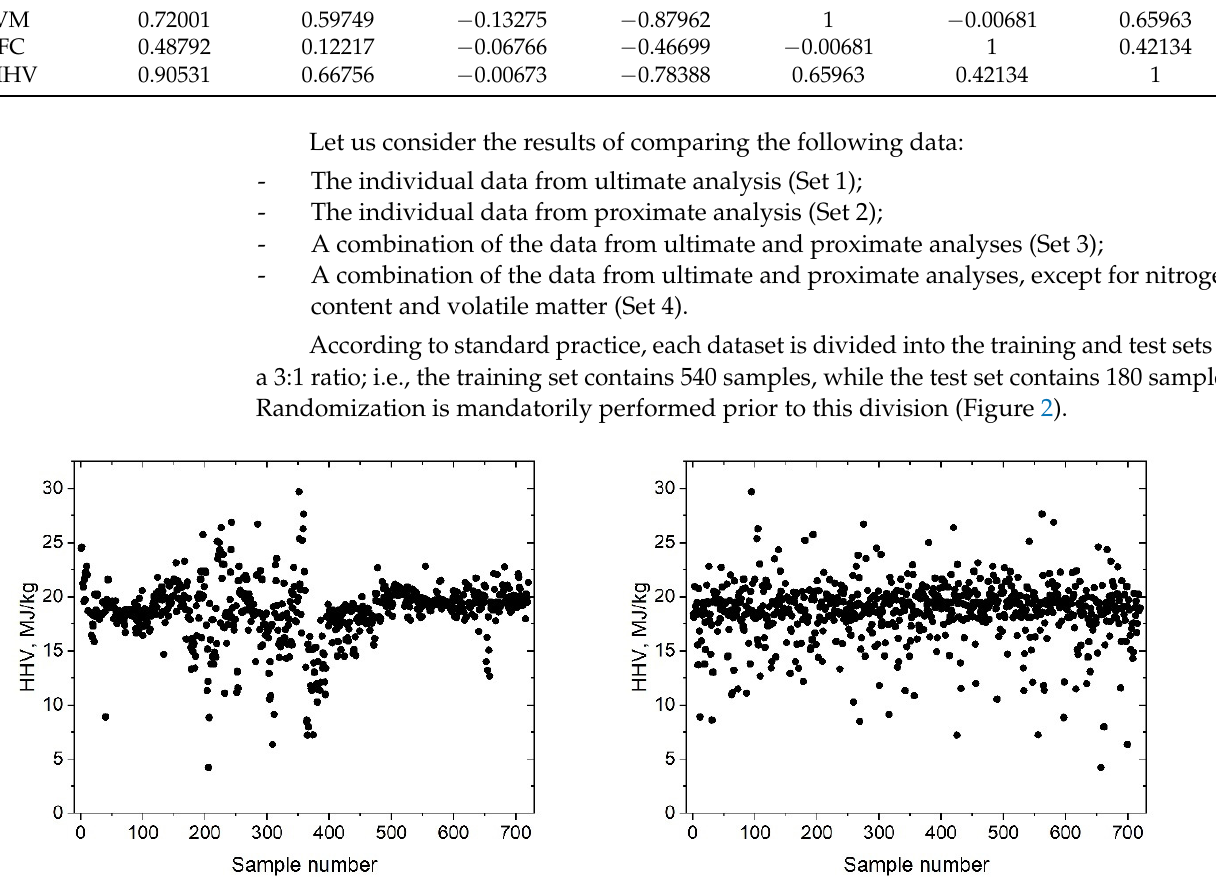
where x.max and x.min are the maximal and minimal values of the input parameter x before scaling, respectively; max and min are the user-defined maximal and minimal X scaled values after scaling, respectively (we used max = 1 and min = − 1).